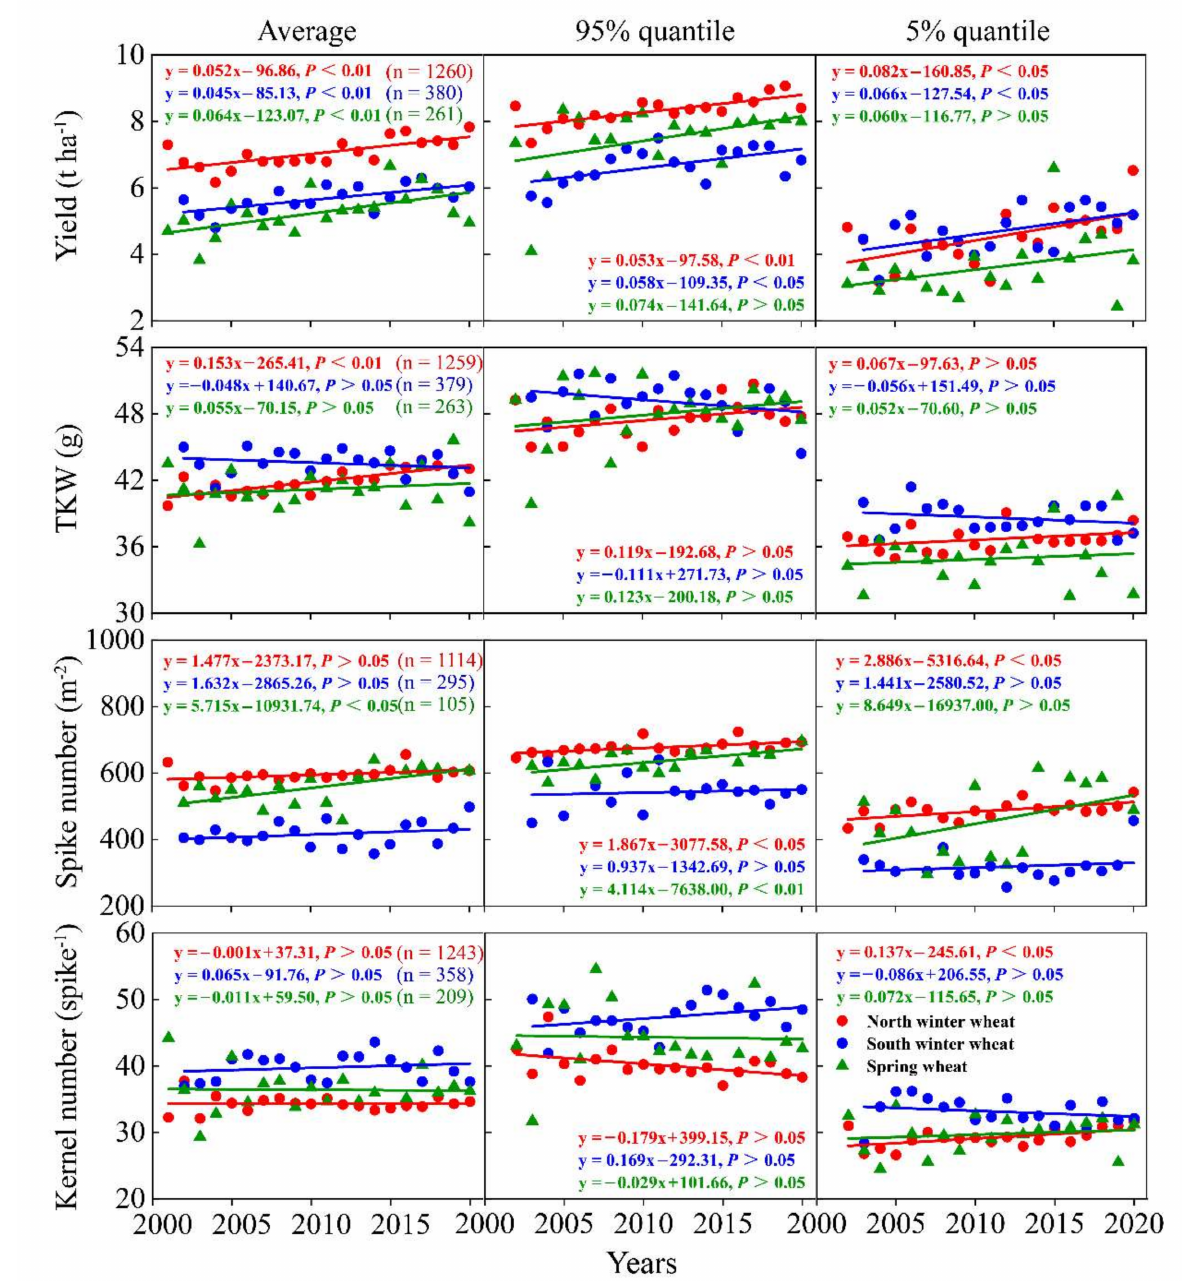
Figure 2. The average value, 95% quantile value and 5% quantile value of grain yield and yield components of wheat varieties released in 2001–2020 for three wheat-growing